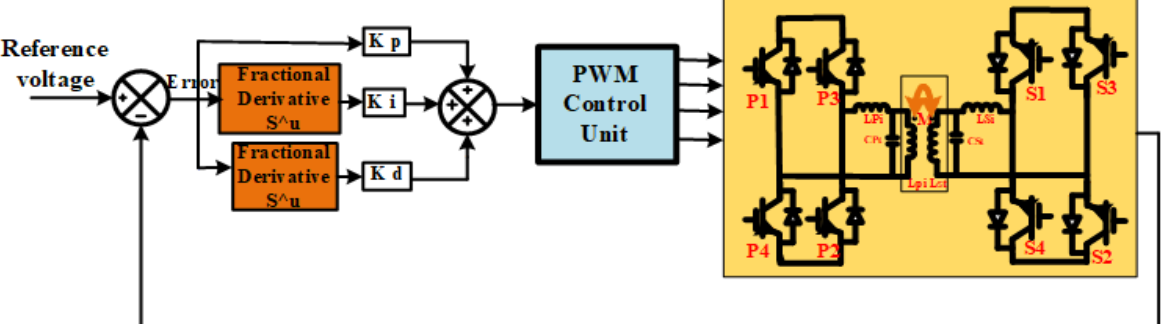
Figure 9. Sliding-mode controller-interfaced BWPT system.